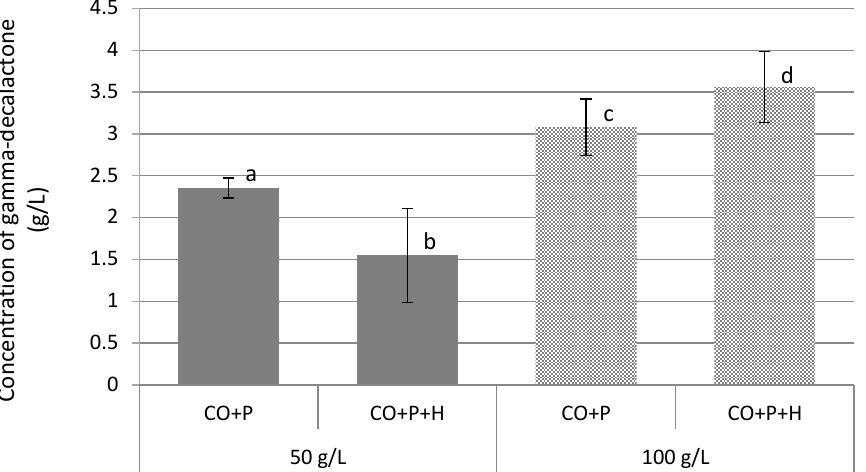
Figure 2. Effect of heptane presence on the maximum level of GDL concentration in biotransformation medium. CO+P: medium with castor oil and peptone; CO+P+H: medium with castor oil, peptone and heptane. Different letters denote significant differences at p < 0.05.